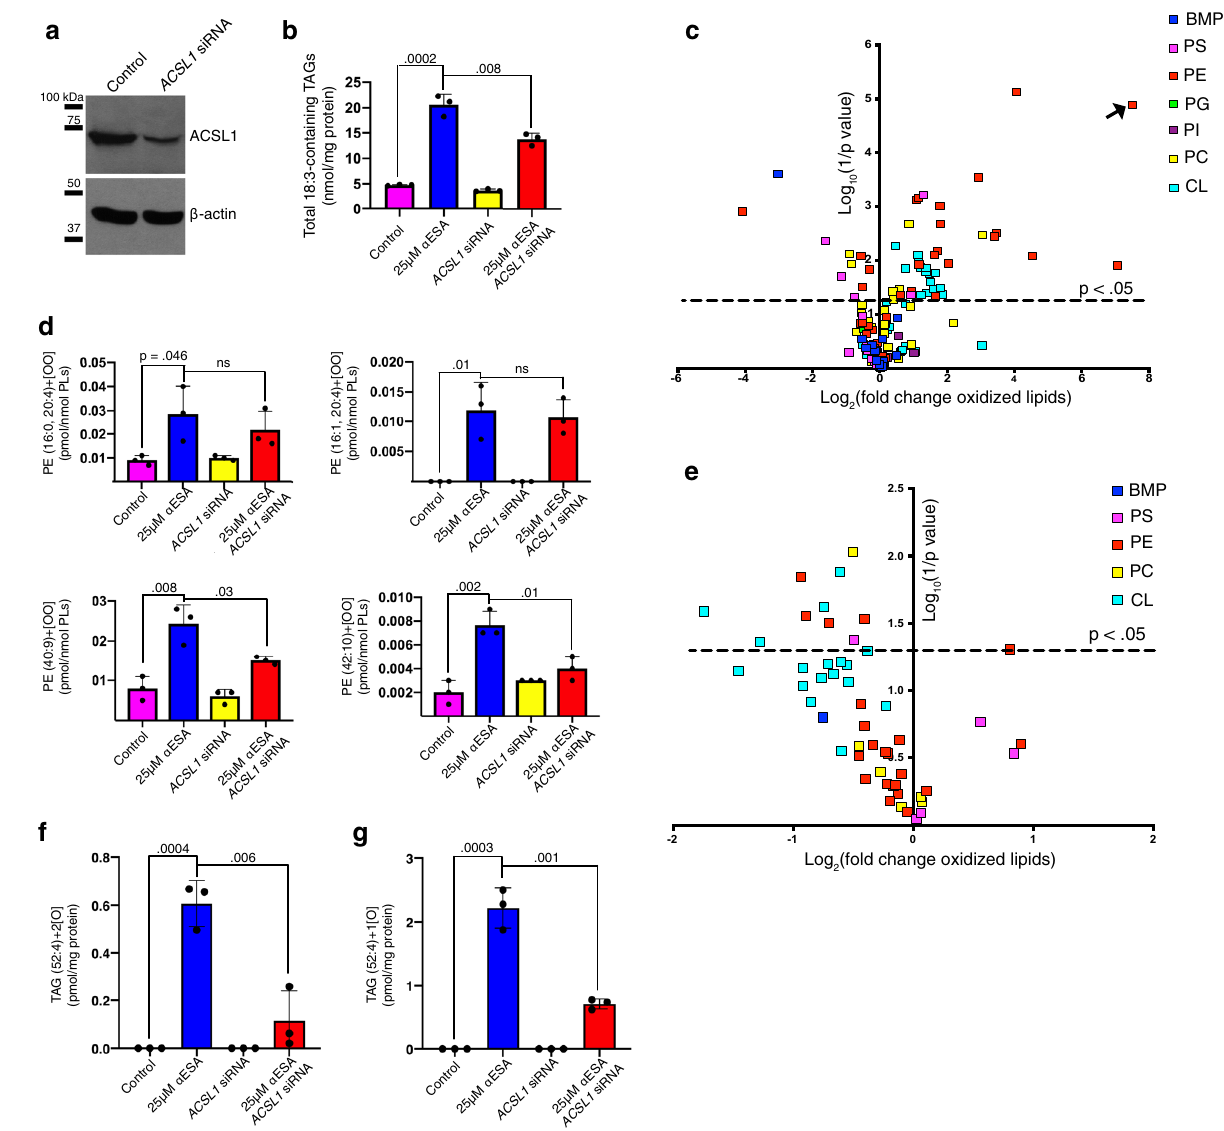
Fig. 7 Lipid peroxidation by α ESA is promoted by ACSL1. a Western blot showing ACSL1 protein expression in control or ACSL1 -silenced cells. The ef fi ciency of the siRNA knockdown was independently con fi rmed using quantitative PCR (qPCR) (Supplementary Fig. 4b). b Bar charts showing the overall amount of 18:3-containing TAGs in BT-549 cells under the speci fi ed condition ( n = 3 biological replicates for this and subsequent bar charts). Cells were treated for 8h with 25 μ M α ESA or vehicle. Treatments were added 72h after transfection with a pool of either ACSL1 -targeting or non-targeting siRNA. In this and subsequent panels, mean values ±standard deviation are presented, and p-values are shown above comparator bars (two-sided Student ’ s t -test). c Volcano plot showing log 2 (fold change) and signi fi cance (log 10 (1/p)) for oxidized phospholipids in BT-549 cells incubated for 8h with 25 μ M α ESA compared to cells incubated with vehicle (methanol). Each lipid species is colored according to phospholipid class. BMP = bis(monoacylglycero)phosphate, PS = phosphatidylserine, PE = phosphatidylethanolamine, PG = phosphatidylglycerol, PI = phosphatidylinositol, PC = phosphatidylcholine, CL = cardiolipin. The arrow indicates a lipid species for which a fold change could not be computed because it was only detected after α ESA treatment. d Bar charts showing the amounts of di-oxygenated PE species that were signi fi cantly increased by α ESA treatment compared to vehicle-treated controls. e Volcano plot depicts log 2 (fold change) versus log 10 (1/ p -value) for oxidized phospholipids in BT-549 cells transfected with a pool of ACSL1 siRNA and incubated with 25 μ M α ESA for 8 h compared to α ESA-treated cells transfected with non-targeting siRNA. The set is limited to the 51 oxidized phospholipid species that were signi fi cantly changed by α ESA treatment as shown in c . Bar charts showing the amount of a ( f ), di-oxygenated and ( g ), mono-oxygenated TAG species that were signi fi cantly increased by α ESA treatment in an ACSL1-dependent manner. Source data are provided as a Source Data fi